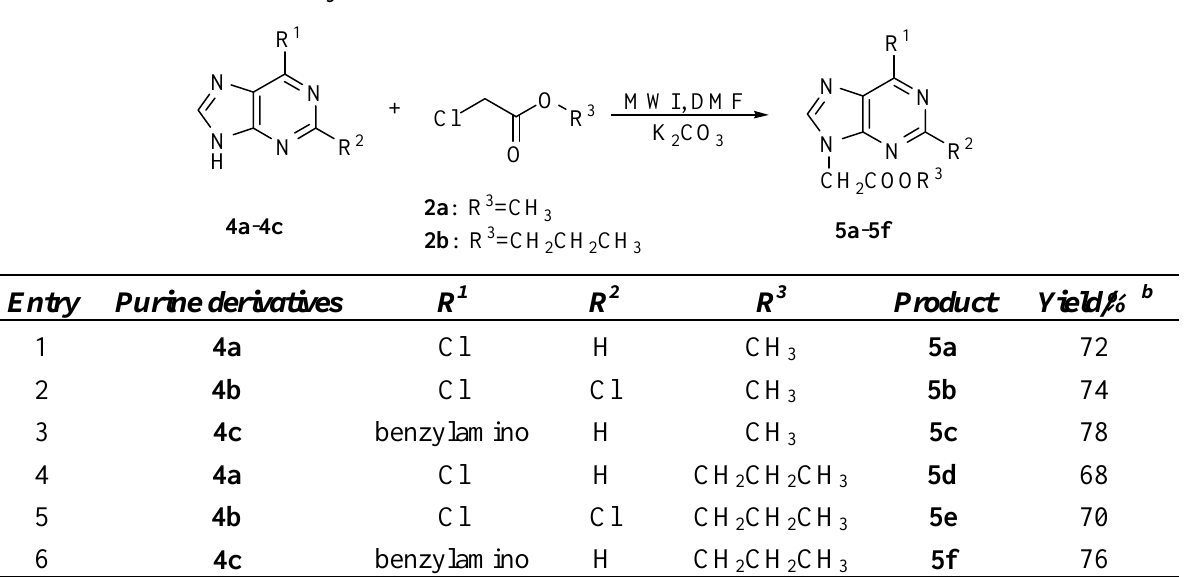
Table 3. Alkylation of Various Purine Derivatives in DMF under MWI a